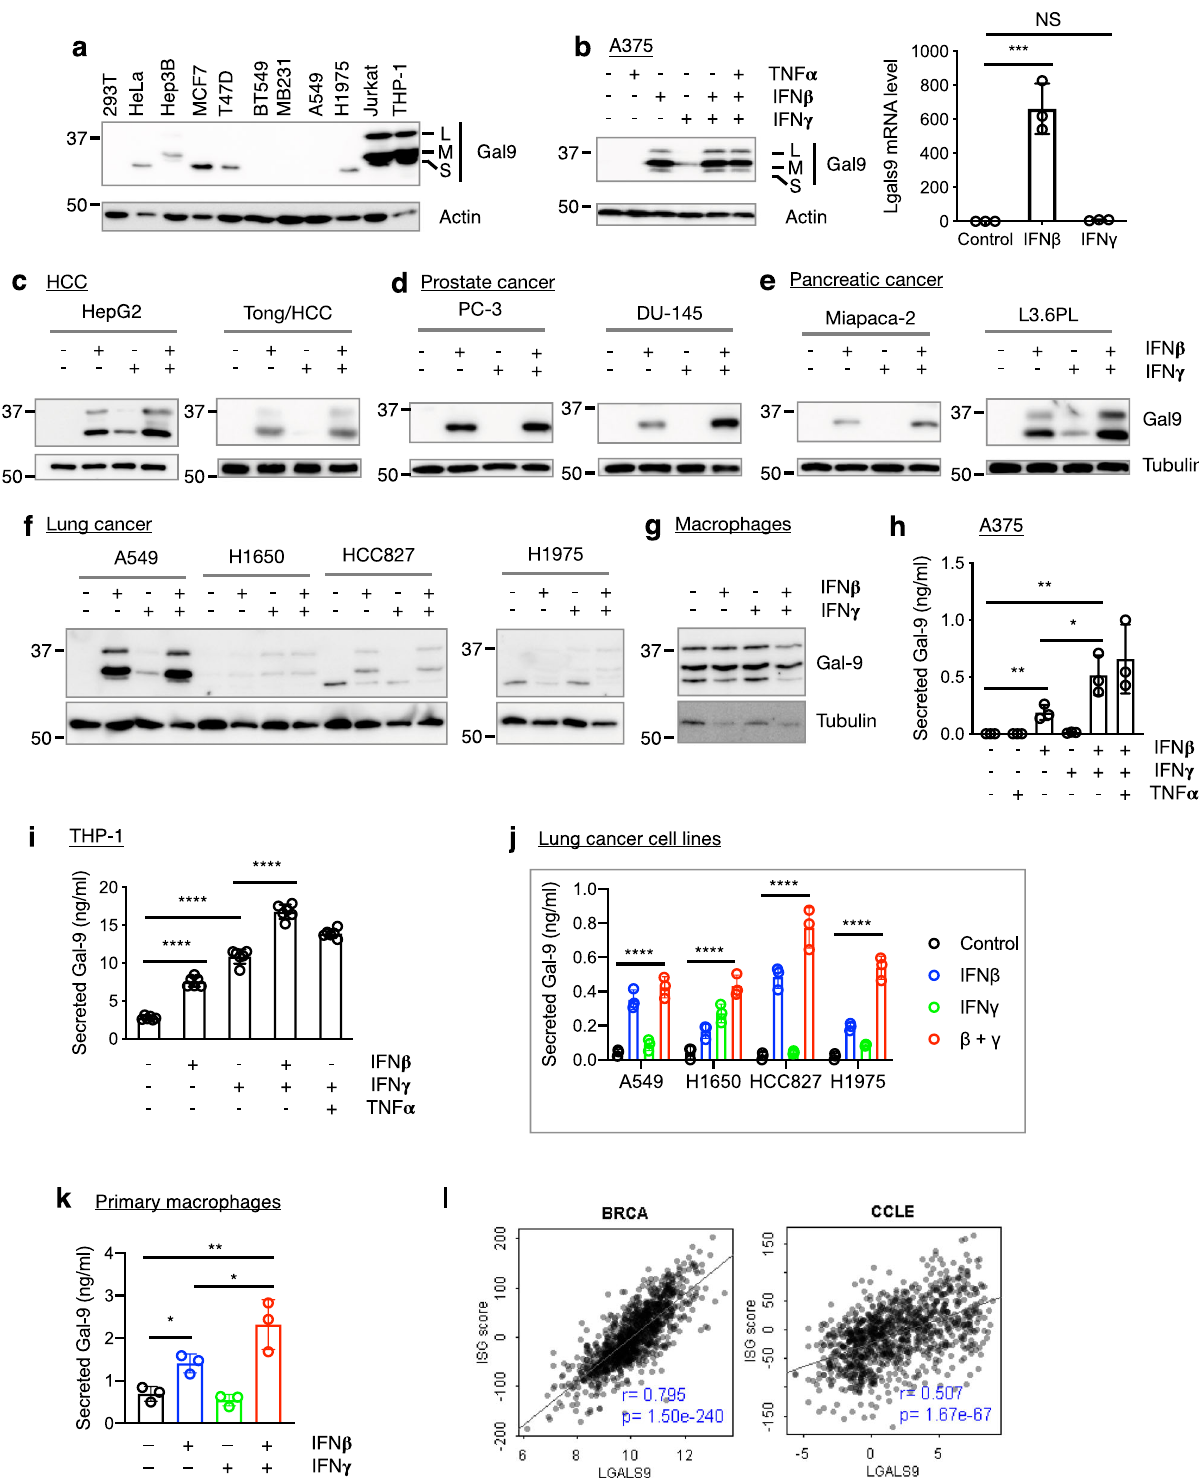
Retro-lentiviral system for doxycycline-inducible gene expression . The origi- nal retroviral vector pMA2641 that carries the gene for the Tet-On reverse transactivator Advanced (rtTA) driven by the viral LTR and the lentiviral vector pMA2867 with a doxycycline-inducible promoter have been described elsewhere 27 . The coding regions for EGFP and mCherry were deleted from those two vectors, giving rise to pMA2642 and pMA2868, respectively. Coding regions for proteins of interest were inserted into pMA2868 in the multiple cloning site downstream of the dox-inducible promoter. Site-directed mutagenesis was made using the Q5 Site- Directed Mutagenesis Kit (New England Biolabs). Another version of the pMA2868 vector (pMA2868H) was made by replacing the puromycin resistance